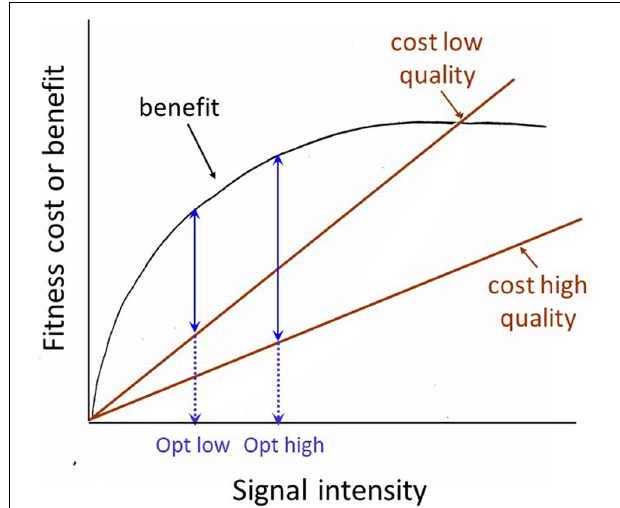
FIGURE 2 | Johnstone’s graphical model of the Handicap principle. The basic assumption is that it costs a high-quality signaler less to signal at its optimum level than it costs a low-quality signaler to signal at that level. The optimum or equilibrium level (where the difference between the costs and benefits of signaling are greatest) for the low quality signaler is lower (opt low) than that for the high-quality signaler (opt high). Thus the signaling level is a reliable indicator of signaler